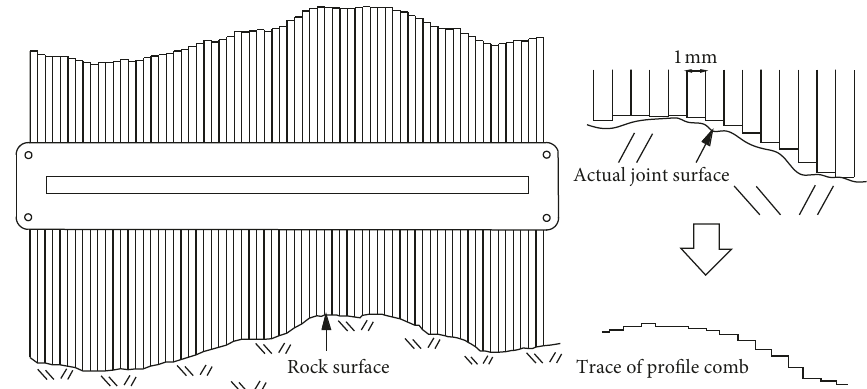
Figure 4: Procedure of using a profile comb to get profile of rock joint [19].